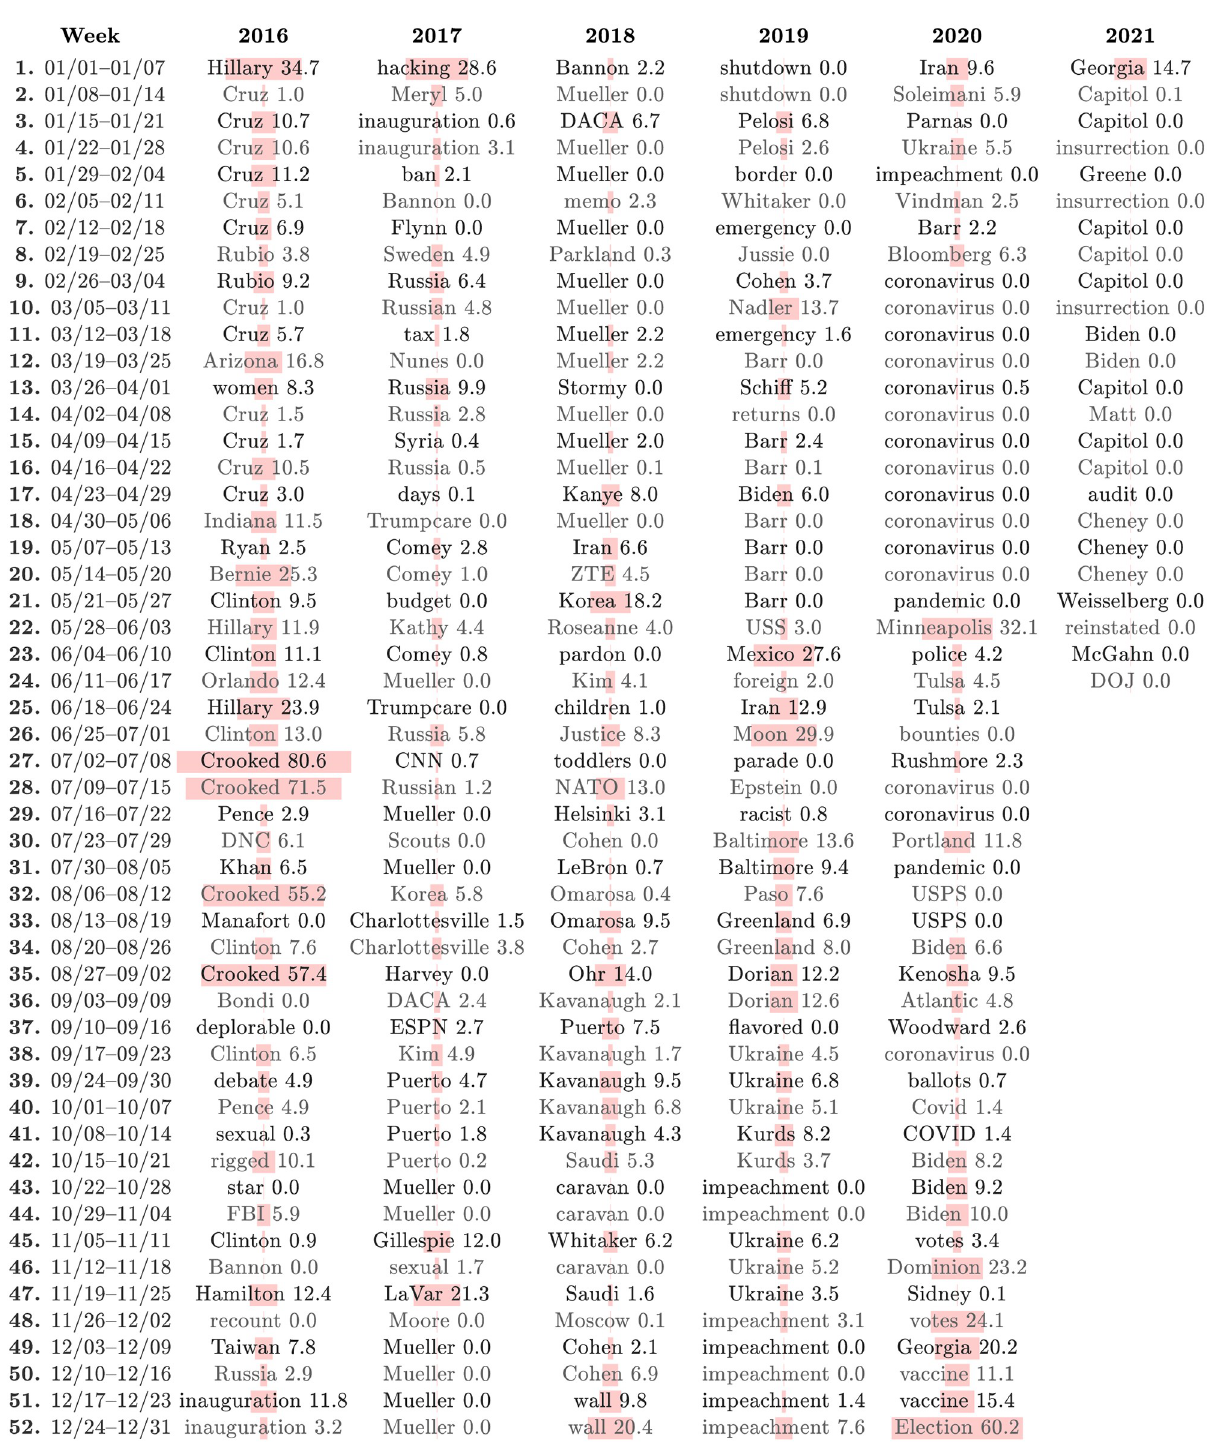
Fig 1. Computational timeline of ‘narratively dominant’ 1-grams surrounding Trump-matching tweets at the week scale. The timelines of 1-grams and 2-grams (Fig 2) give an overall sense of story turbulence through turnover and recurrence. For each week, we show the 1-gram with the highest sum of rank-turbulence divergence (RTD) contributions [37] relative to the year before, based on comparisons of day-scale Zipf distributions for 1-grams in Trump-matching tweets. See S1 Fig for a full example of 2021/01/06, the day of the Capitol insurrection. Each 1-gram must have been the most narratively dominant for at least 1 day of the week (i.e., highest RTD contribution). The numbers and pale pink bars represent Trump’s narrative control as measured by the percentage of an n -gram appearing in retweets of Trump’s own tweets during a given week. The limits of 0 and 100 for